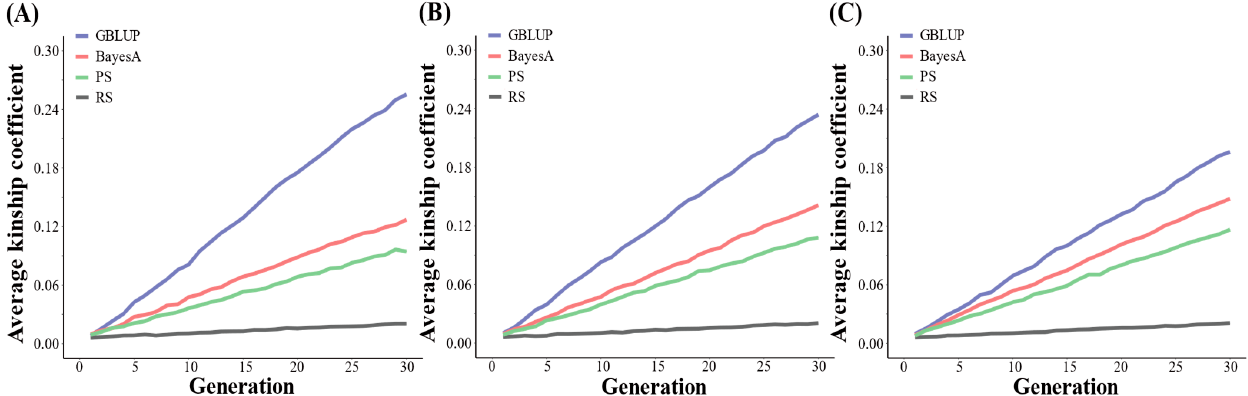
Figure 6. Average kinship coefficients of 4 strategies with low, medium, and high heritability traits using 100 K SNPs. ( A ) Average kinship coefficients for trait heritability of 0.1. ( B ) Average kinship coefficients for trait heritability of 0.3. ( C ) Average kinship coefficients for trait heritability of 0.5.